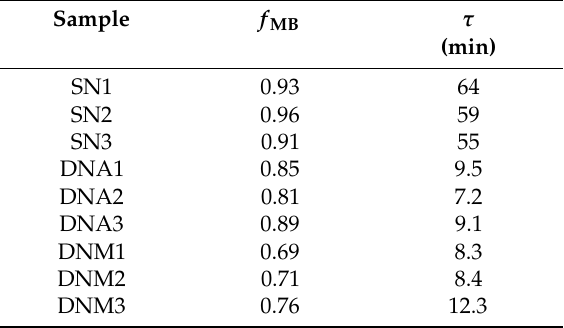
Figure 8. Time dependence of methylene blue (MB) concentration for release process for ( a ) SN2 hydrogel and ( b ) DNA2 and DNM2 hydrogels at 45 ◦ C. Experimental points are fitted according to Equation (4). Table 6. Parameters related to MB release fitted from Equation (4): the equilibrium fractions of released MB f MB and the release delay time τ